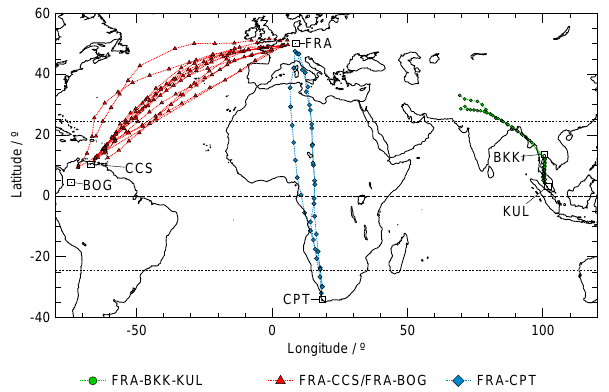
Fig. 1. Collection locations of whole air samples for CARIBIC flight routes FRA-CCS/BOG, FRA-CPT and FRA-BKK-KUL. For the latter, air sample collection north of approximately 30 ◦ N were not analysed at